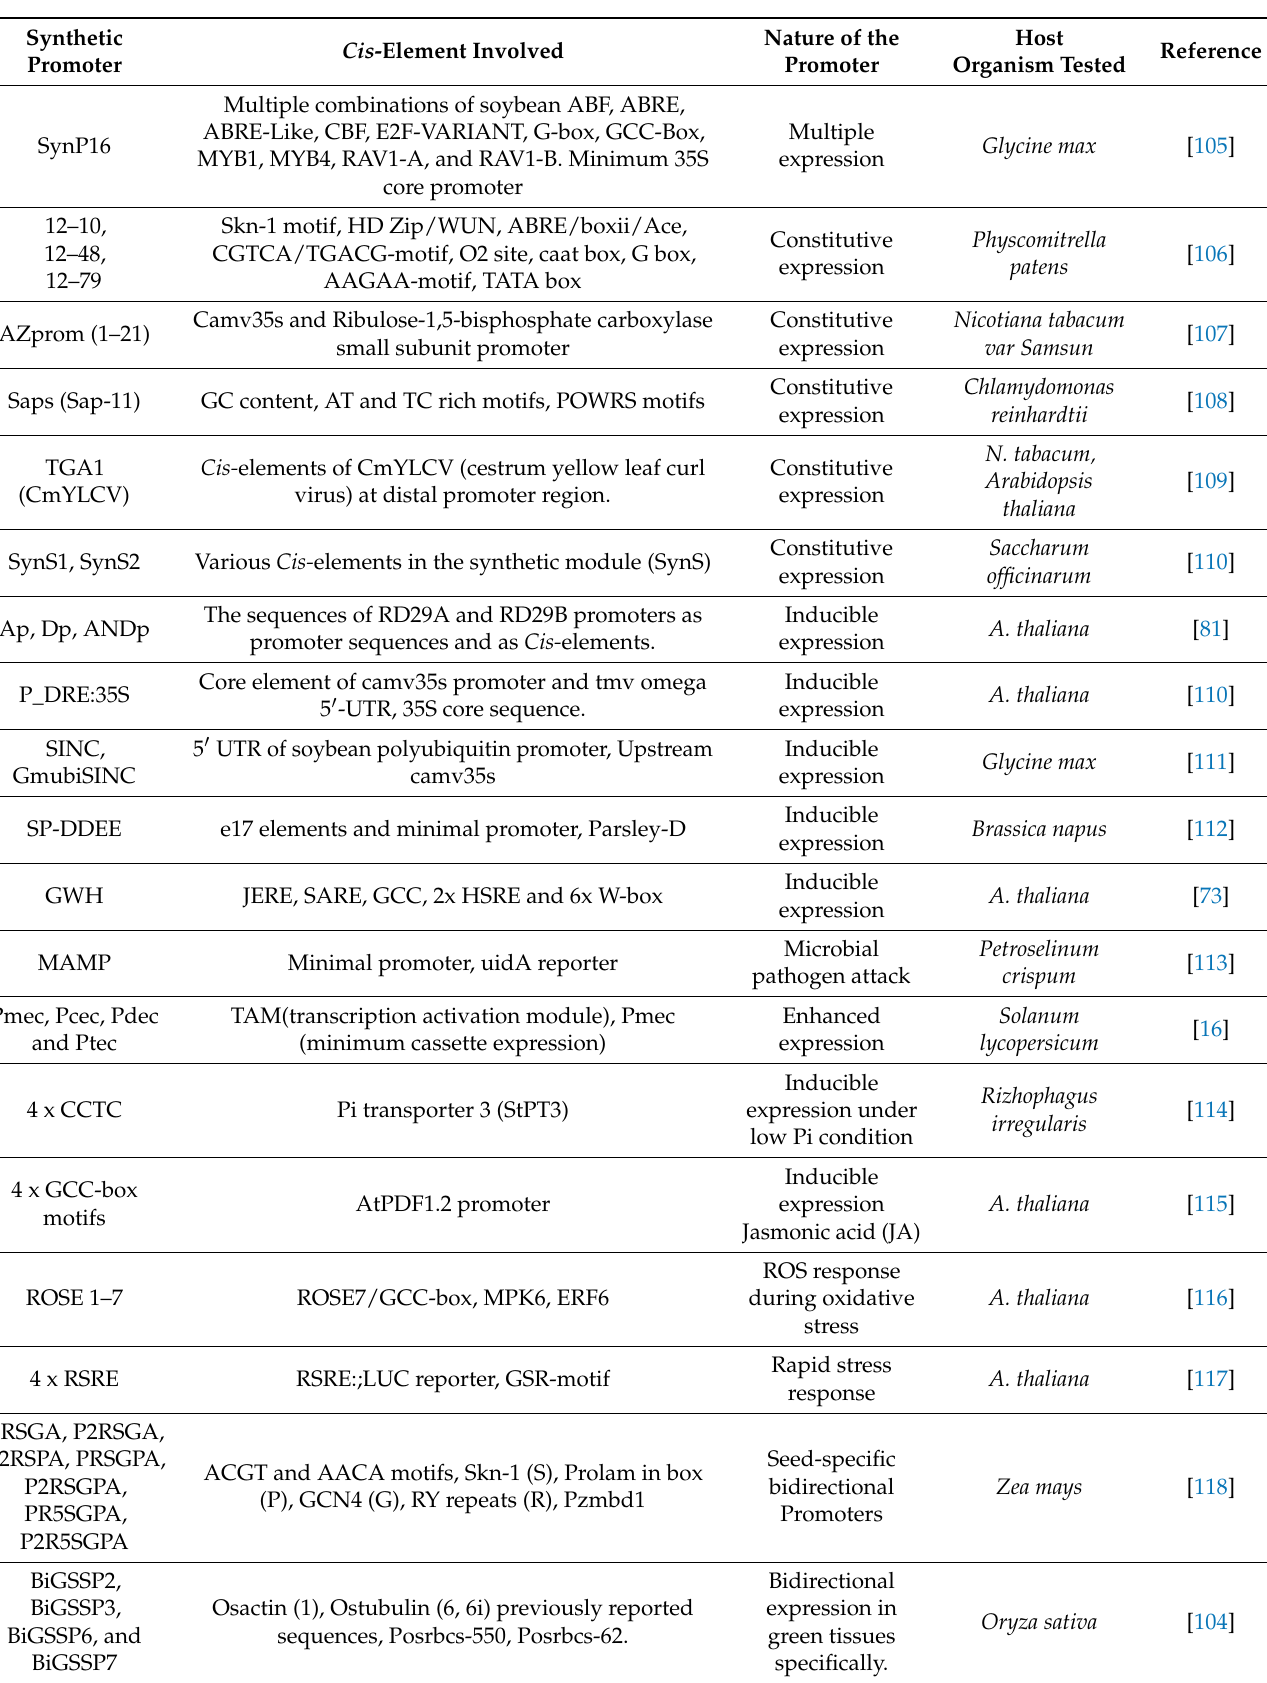
Table 2. List of synthetic